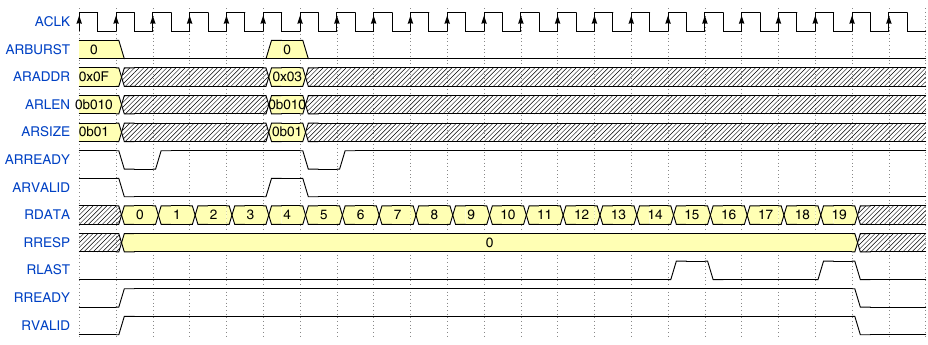
Figure 11. AXI outstanding mode timing diagram in read mode.